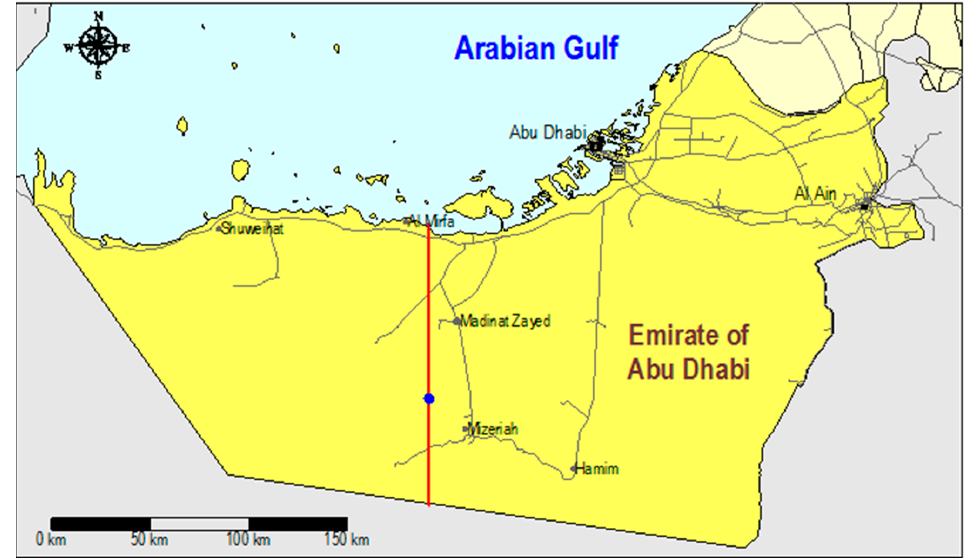
Figure 1. Location of the Liwa Strategic Water Storage and Recovery (SWSR) Project: the blue dot on the red line. From GTZ-Dornier (with permission): [10].